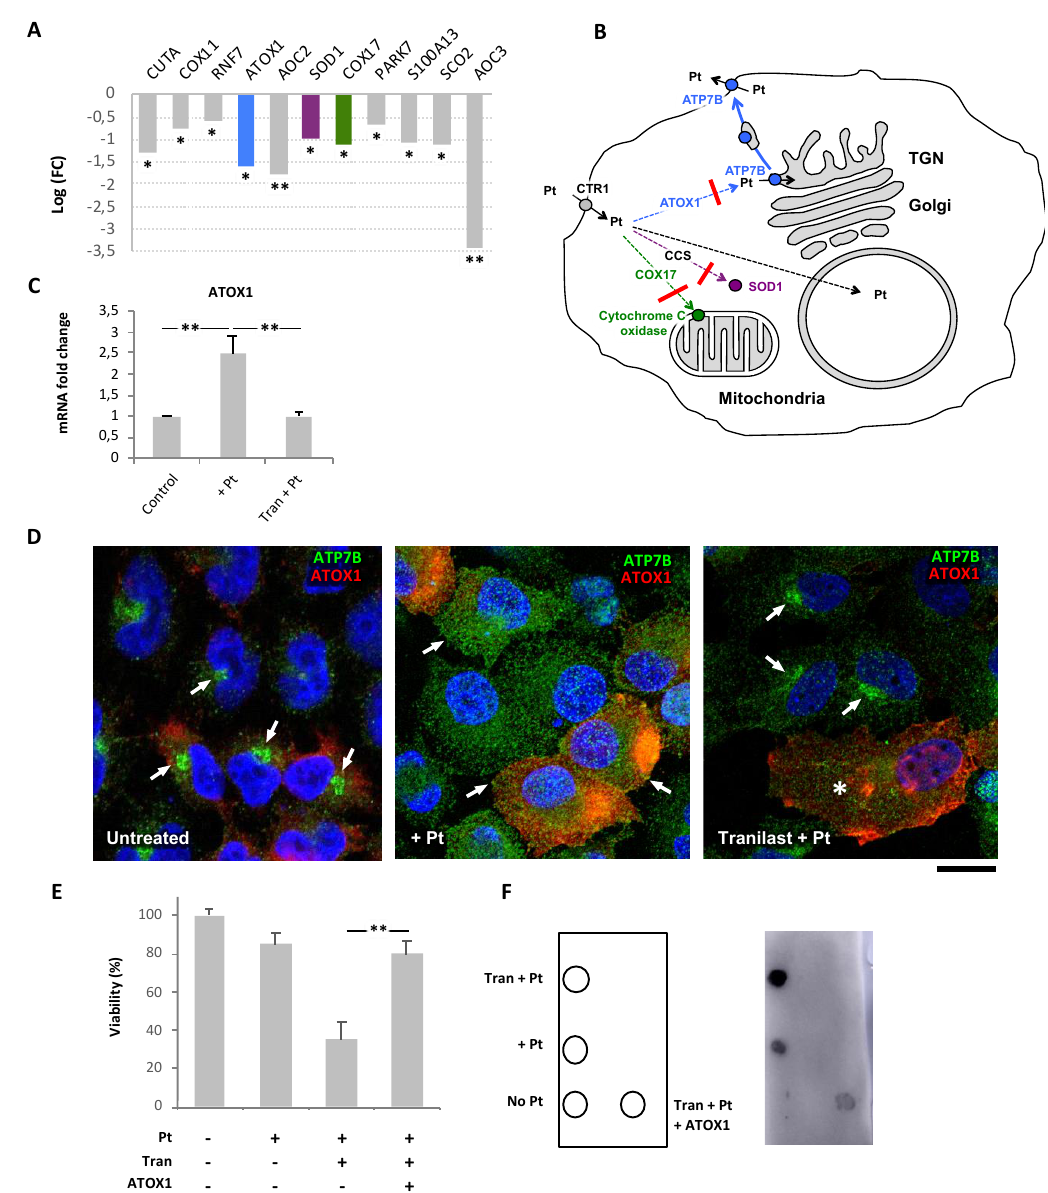
Figure 6. Impact of Tranilast on Pt-transporting pathways in cisplatin-resistant IGROV-CP20 cells. ( A ) QuantSeq analysis shows the impact of Tranilast on the expression of the copper ion binding genes in cisplatin-treated IGROV-CP20 cells ( n = 3 experiments; * p < 0.05, ** p < 0.01, ANOVA). The genes playing a key role in the distribution of Pt across the cell (ATOX1, SOD1, and COX17) are shown in di ff erent colors corresponding to the specific intracellular route shown in panel B. ( B ) The scheme depicts Pt intracellular routes. Downregulation of ATOX1, SOD1, and COX17 by Tranilast (red crossbars) inhibits Pt delivery to the secretory pathway (blue arrows), mitochondria (green arrows), or SOD1-mediated detoxification pathway (magenta arrow). This favors delivery of Pt to the cell nucleus (dashed black arrow) leading to enhanced DNA damage. ( C ) qRT-PCR showed an increase in ATOX1 mRNA in cells treated with 50 µ M cisplatin, while Tranilast inhibited Pt-mediated induction of ATOX1 expression ( n = 3 experiments; ** p < 0.01, ANOVA). ( D ) IGROV-CP20 cells were transfected with pCDNA-ATOX1-FLAG and treated with 50 µ M ciaplatin (Pt) or with a combination of 10 µ M Tranilast and Pt (as indicated in the figure). The cells were then immuno-stained for ATP7B and FLAG. ATP7B was detected in the Golgi area in untreated cells (arrows, left panel) and at the cell surface and peripheral structures in Pt-treated cells (arrows, mid panel) regardless of ATOX1 overexpression. Tranilast blocked ATP7B in the Golgi area in Pt-treated cells, which did not overexpress ATOX1 (arrows, right panel), but failed to inhibit Pt-mediated redistribution of ATP7B